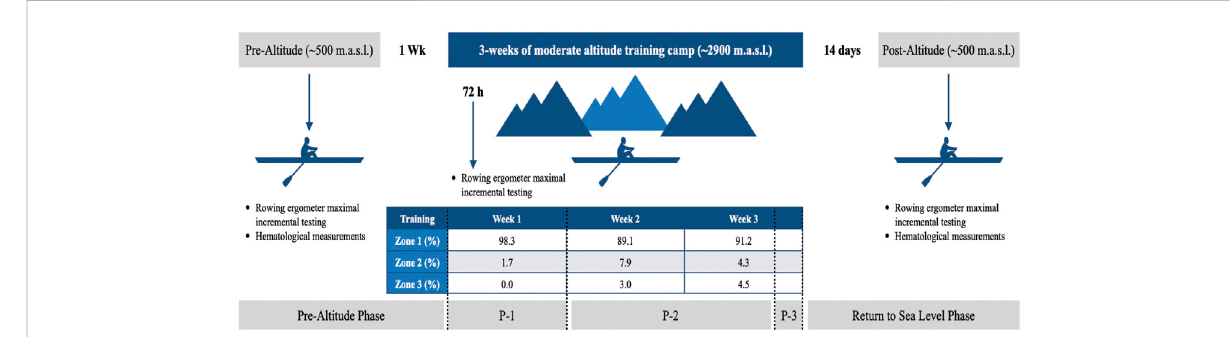
FIGURE 1 Schematic timeline of study design. The athletes were measured pre-intervention (pre-altitude) and 14 days after returning to sea level (post- altitude). m. a.s.l. meters above sea level; Wk: week. Zone 1: performed below the fi rst ventilatory threshold (pVT1); Zone 2: performed between the fi rst and second ventilatory thresholds (pVT1 and pVT2); Zone 3: performed above the second ventilatory threshold (pVT2). These zones were obtained in a rowing ergometer maximal incremental testing conducted 72 h after arriving at altitude. P-1: acclimatization phase; P-2: primary training phase; P-3: recovery and preparation for return to sea level